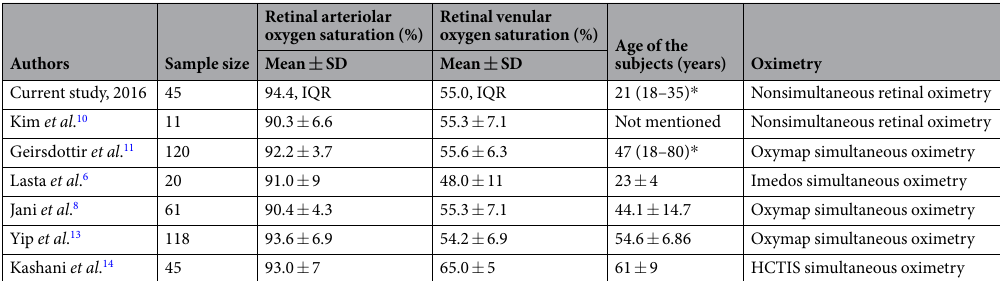
Table 4. Retinal Oxygen Saturation Values in Healthy Individuals across the Literature. HCTIS, hyperspectral computed tomographic imaging spectroscopy; IQR, interquartile range; SD, standard deviation. * Values in median